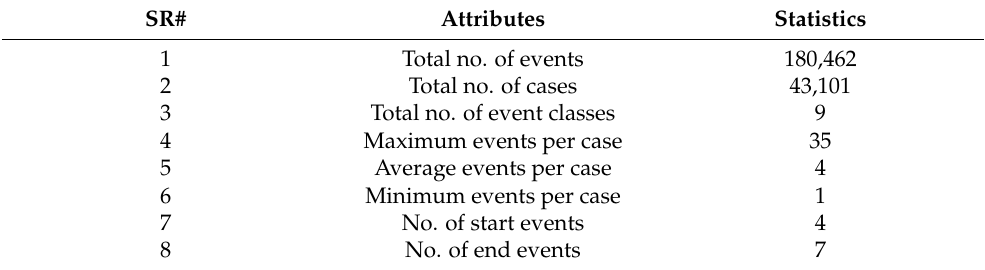
Table 1. Global statistics of log data.